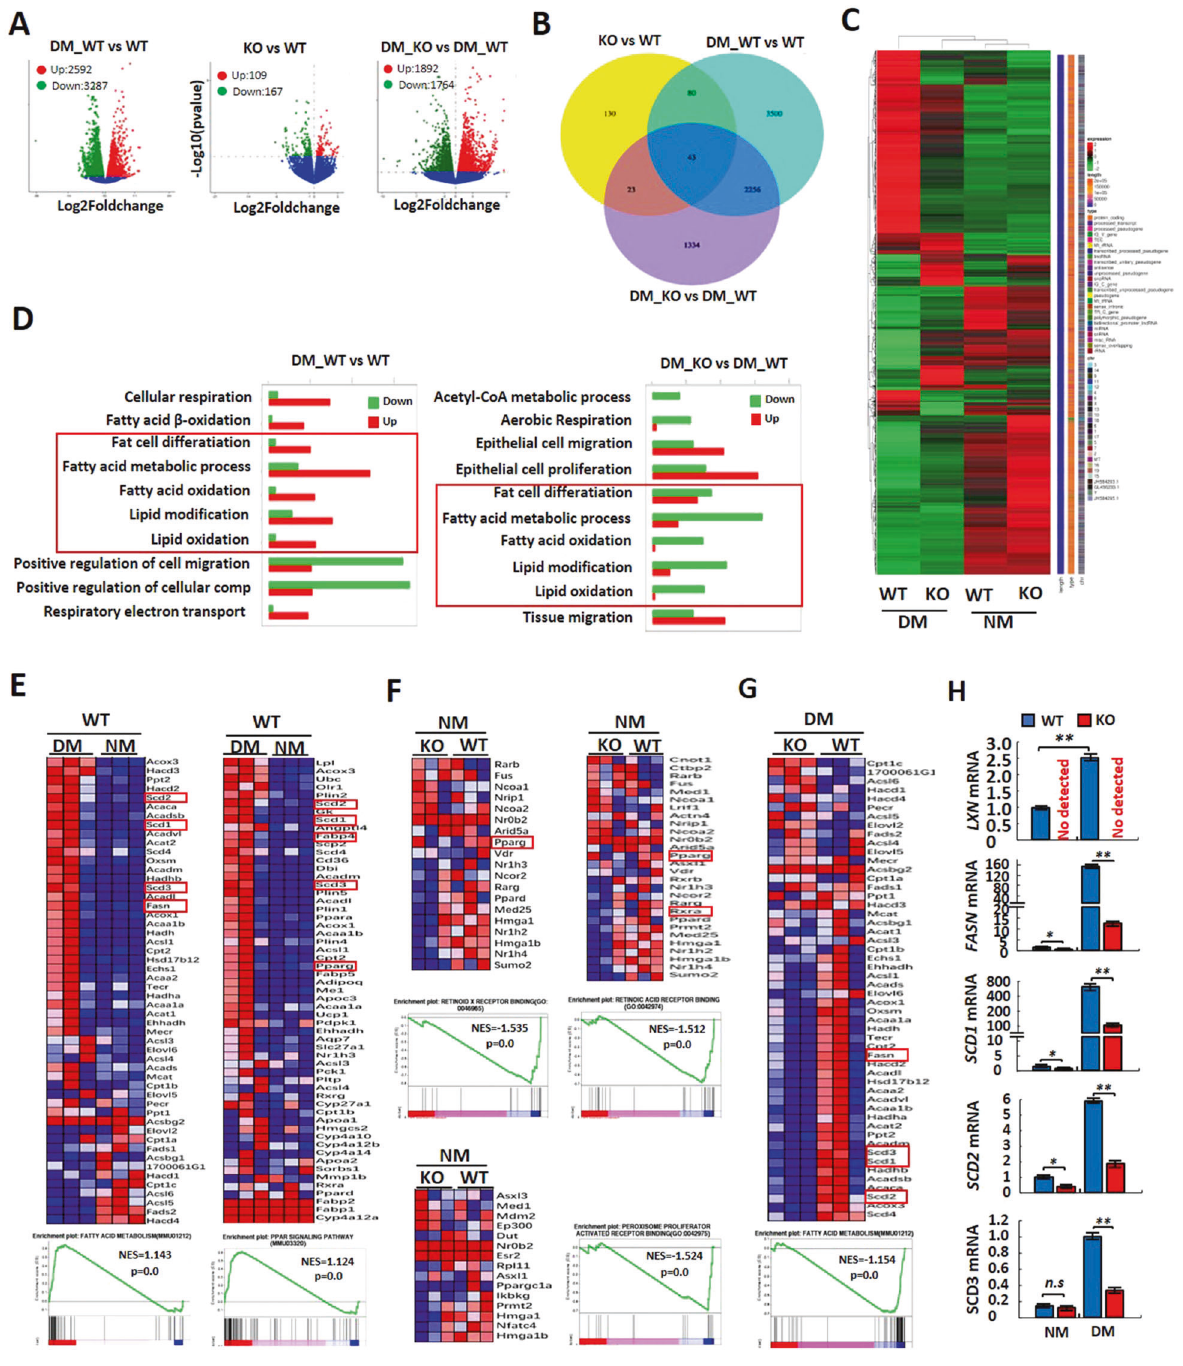
Fig. 4 RNA sequencing reveals down-regulation of PPAR ɤ targeted genes in preadipocytes after deletion of LXN. A Volcano plot of differentially expressed genes (DGEs) in WT and KO preadipocytes cultured with normal medium (KO vs WT), WT preadipocytes cultured with normal medium and differentiation medium (DM_WT vs WT) and WT or KO preadipocytes cultured with differentiation medium (DM_KO vs DM_WT). B The overlapping genes identi fi ed in different experimental groups. C DEGs identi fi ed by RNA-seq were presented in Heatmap. D GO enrichment analysis of DEGs in DM_WT vs WT group (left) and DM_KO vs DM_WT group (right). E – G Heatmap shows the GSEA of representative KEGG pathway in WT preadipocytes cultured with differentiation medium or normal medium ( E ), WT and KO preadipocytes cultured with normal medium ( F ) and differentiation medium ( G ). H Real-time PCR results for analysis of LXN and PPAR ɤ targeted genes in WT or KO preadipocytes under normal medium or differentiation medium. All results were presented as mean ± SD. * P < 0.05, and ** P < 0.01, ns: no signi fi these gene groups were mostly downregulated in DM-induced vs DM_KO). Our data show that those upregulated genes were LXN -/- preadipocytes as compared with DM-induced WT pre- enriched for fat cell differentiation, fatty acid metabolic process, fatty acid oxidation, lipid modi fi cation and lipid oxidation when adipocytes (Fig. 4D). Gene set enrichment analysis (GSEA) further WT preadipocytes were treated with DM for three days; whereas con fi rmed the upregulation of fatty acid metabolism and PPAR ɤ